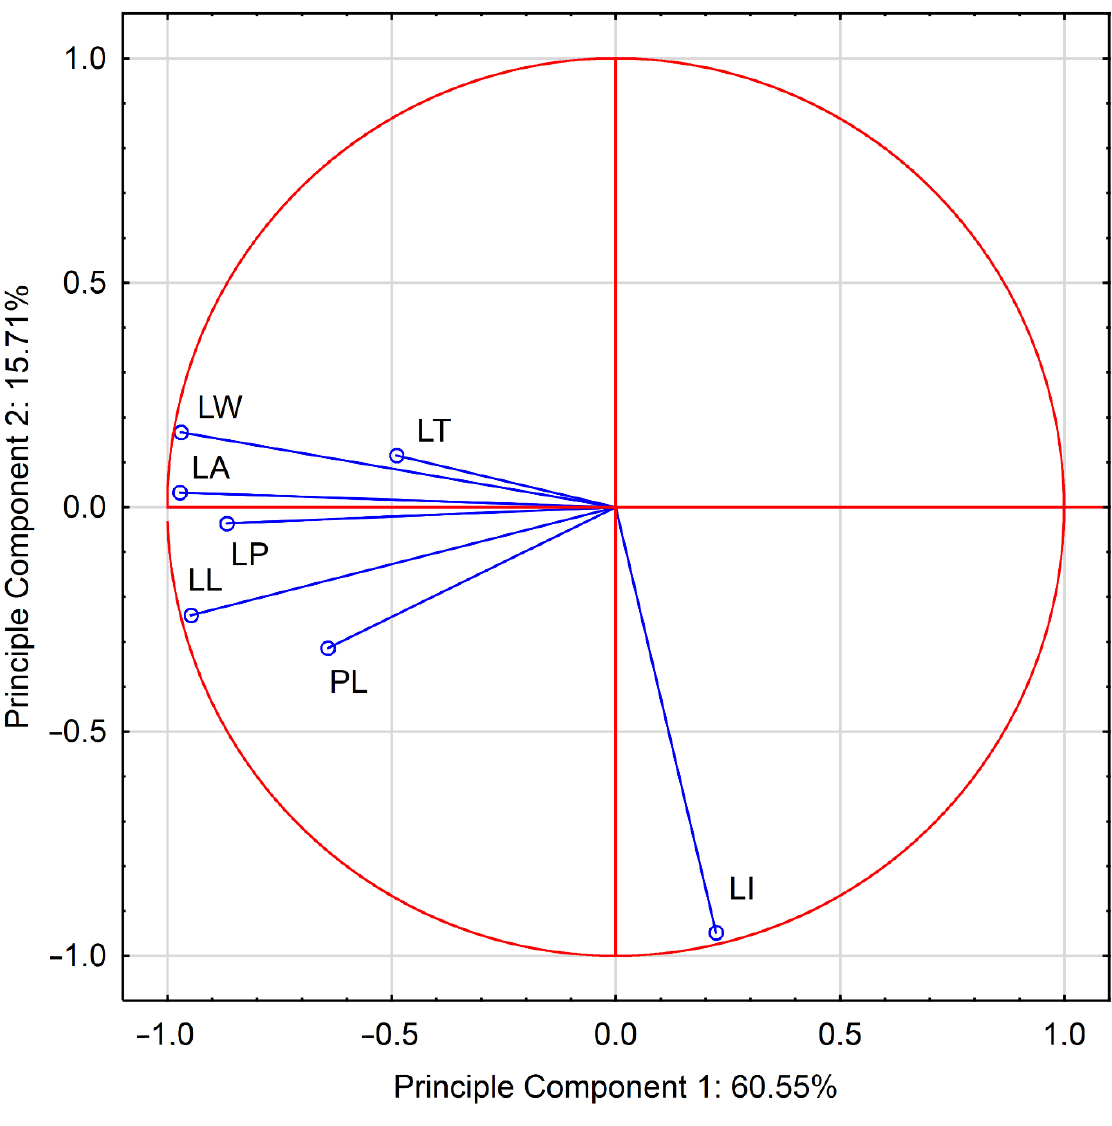
Figure 8. Principal component analysis of the morphological parameters of the sun and shade beech leaves. The first two principal components are plotted. LA — leaf area, LT — leaf thickness, LP — leaf perimeter, PL — petiole length, LW — leaf width, LL — leaf length, LI — leaf index. Based on the PCA of leaf biochemical parameters, five factors met the Kaiser criterion and explained 49.87% of the variation (Figure 9). The value of the KMO coefficient was 0.532, with small-molecule antioxidants showing the lowest KMO values (mean 0.522) and assimilatory pigments and antioxidant enzymes showing the highest (mean 0.719). The criterion derived from Bartlett’s test was also met (chi-square test value 9774.04, p < 0.001). The first component explained 34.98% of the variability, whereas the second explained 14.89%. Biochemical parameters were categorized into four groups: A, B, C, and D (Figure 9). Strong relationships were found between chlorophylls and carotenoids (markers of leaf senescence) (group A). The decomposition of leaf pigments initiated ROS formation, lipid peroxidation, and an increase in the carotenoid/chlorophyll ratio (group B). Oxidative stress was found to be responsible for an increase in the activity of the antioxidant system composed of small-molecule antioxidants and antioxidant enzymes, which constituted groups C and D of biochemical parameters (Figure